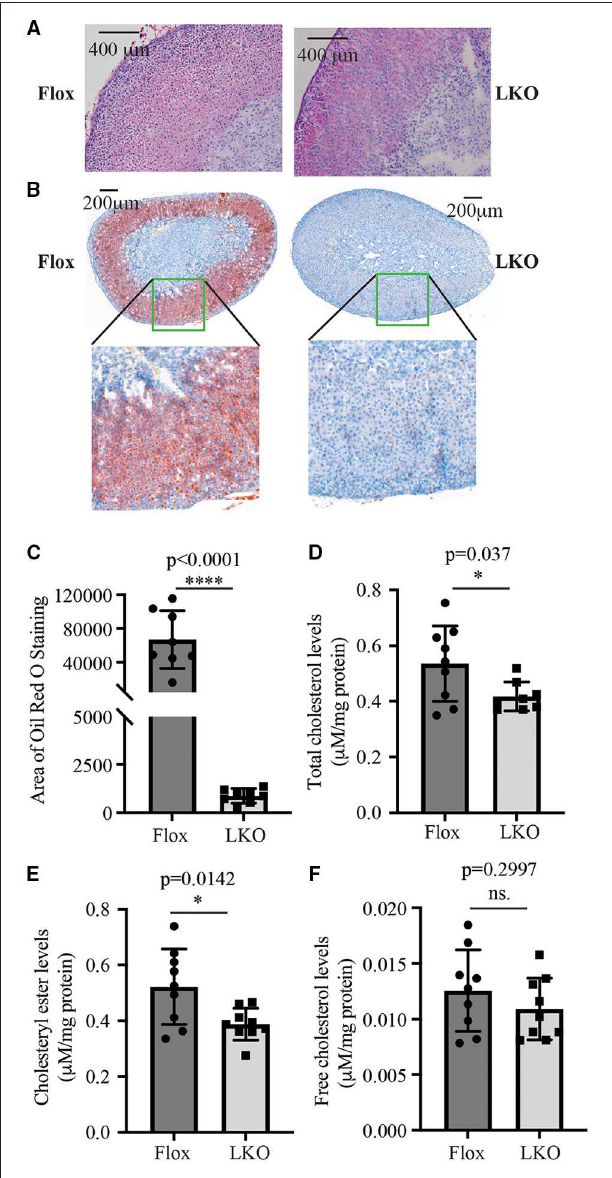
FIGURE 2 | Impact of lacking hepatic Surf4 on the adrenal gland. (A) H&E staining of adrenal sections. (B,C) Oil Red O of adrenal sections. Representative figures were shown. Similar results were obtained in other mice. The images of Oil Red O staining were quantified using ImageJ (C) (8 mice per group). Data were analyzed by a Student’s t -test ( p < 0.0001) and a Mann Whitney test ( p = 0.0002). (D–F) Adrenal total cholesterol (D) , cholesteryl ester (E) , and free cholesterol (F) levels. Lipids were extracted from mouse adrenal glands using the MTBE method and then subjected to total cholesterol and free cholesterol measurement using their specific enzymatic kit. Cholesteryl ester levels were calculated by subtracting free cholesterol from total cholesterol. Values of all data were mean ± S.D. The significance was defined as * p < 0.05 and **** p < 0.0001, p > 0.05, no significance (ns.).